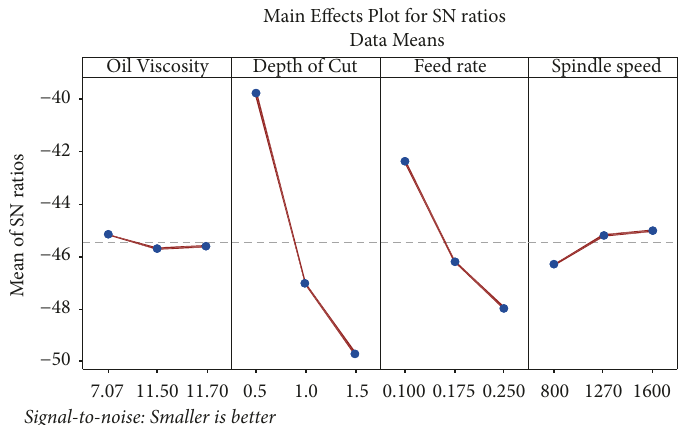
Figure 4: Main effects plot for cutting force.